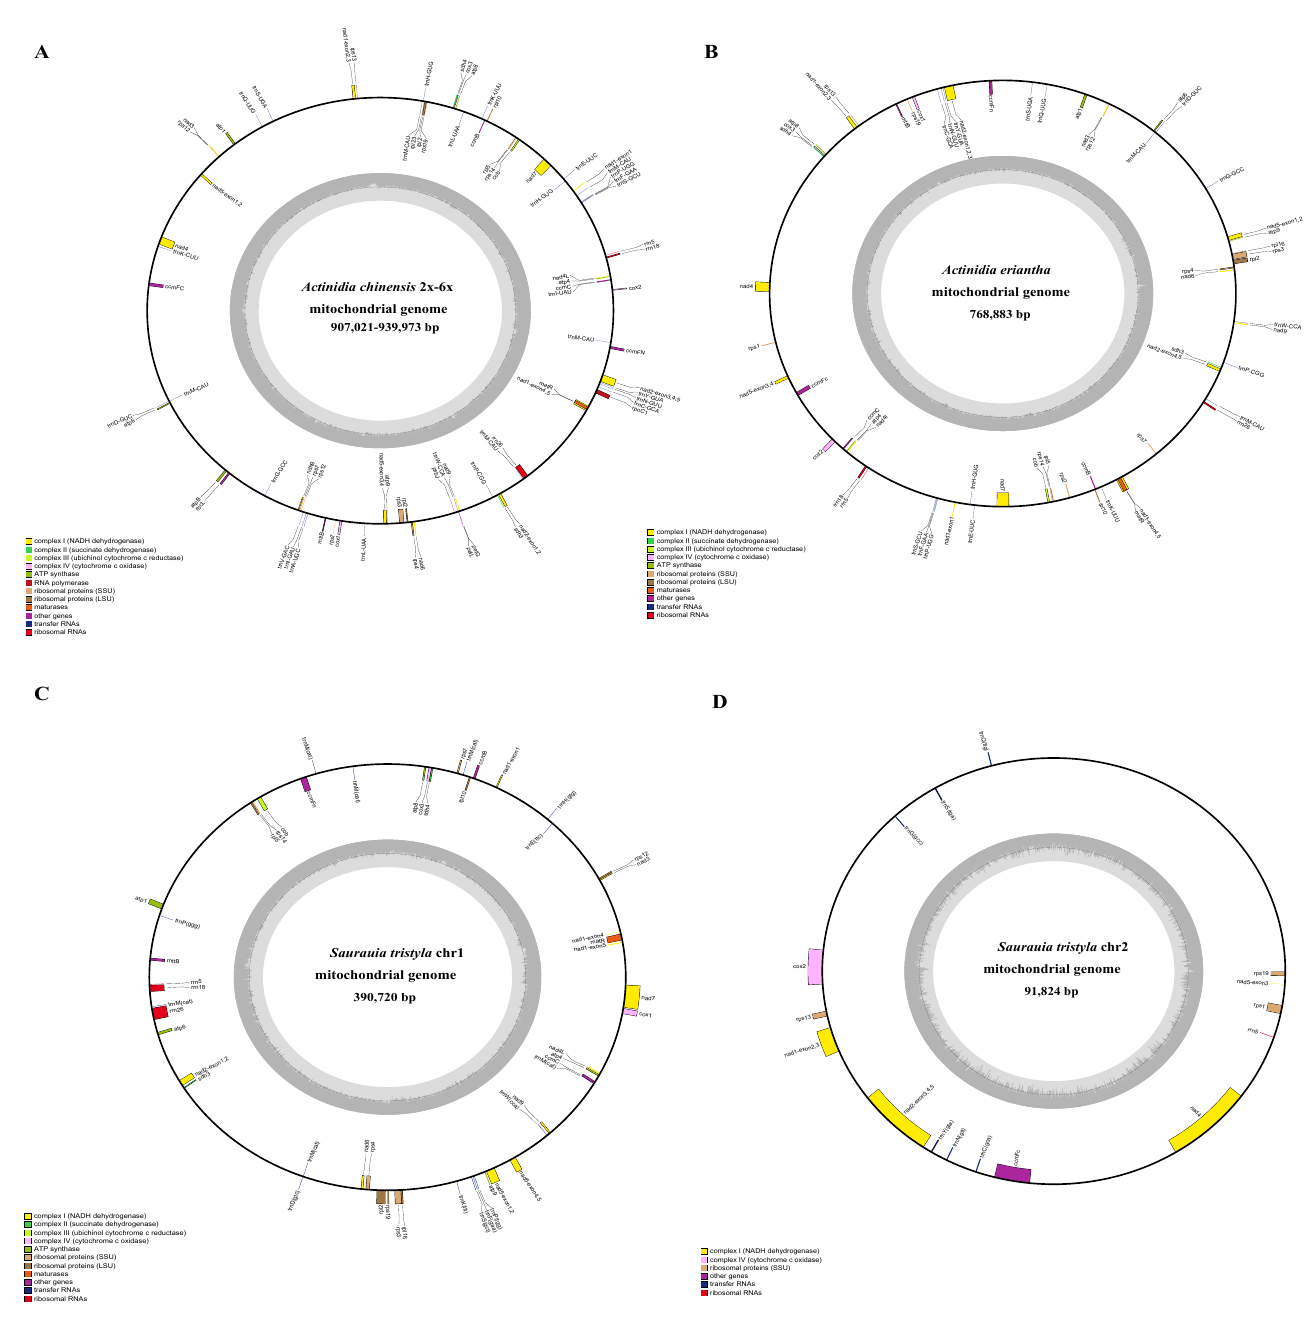
Figure 1. ( A – D ) Gene map of four kiwifruit species ( A. chinensis (2 × –6 × ), A. eriantha ) and S. tristyla, representing the mitogenome structure. Genes drawn outside the circle are transcribed clockwise, and those inside are counterclockwise. Genes that belong to different functional groups are color coded. The darker grey in the inner circle indicates the GC content of the